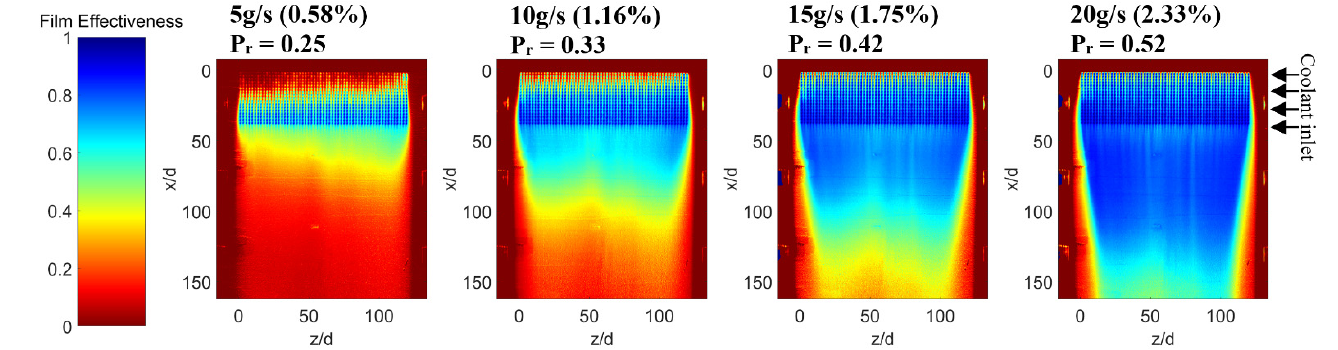
Figure 3. Film effectiveness of Panel 2 at different coolant mass flow rates (mass fraction).